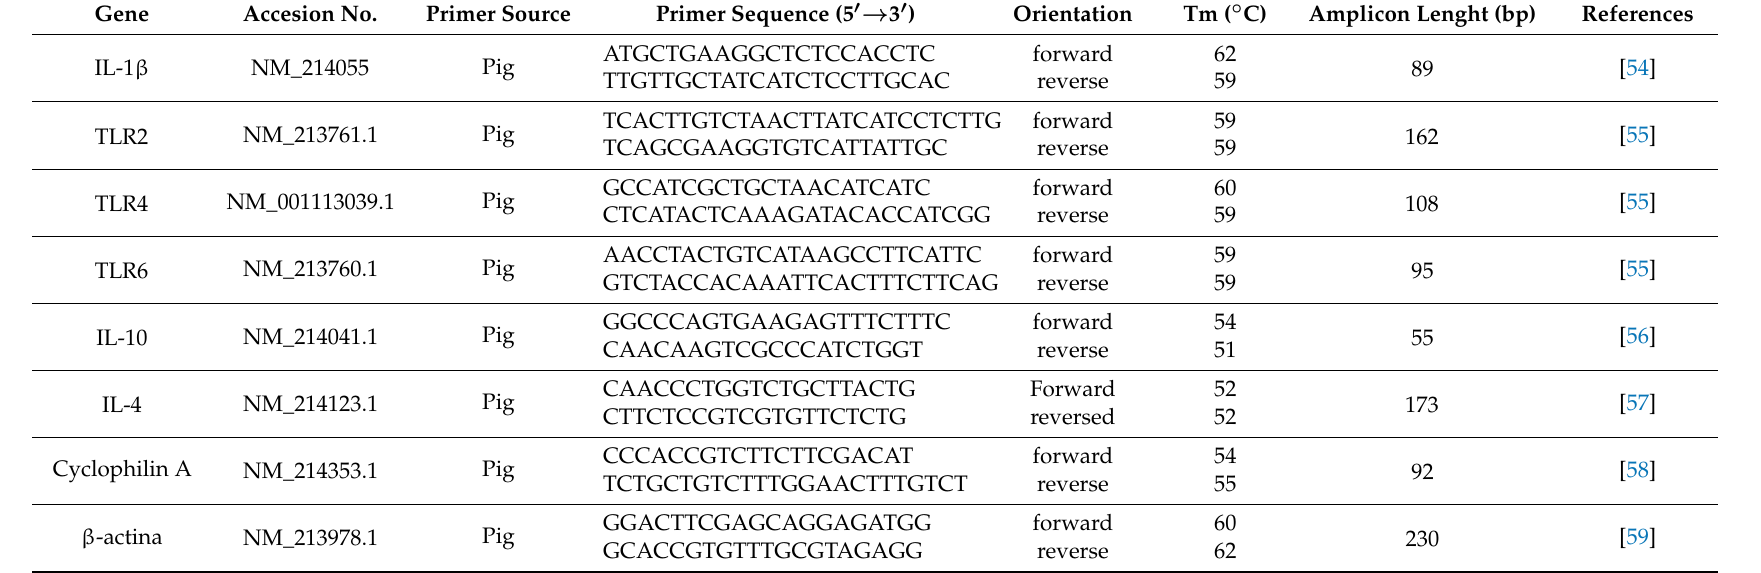
Table 10. Oligonucleotide Polymerase chain reaction (PCR)